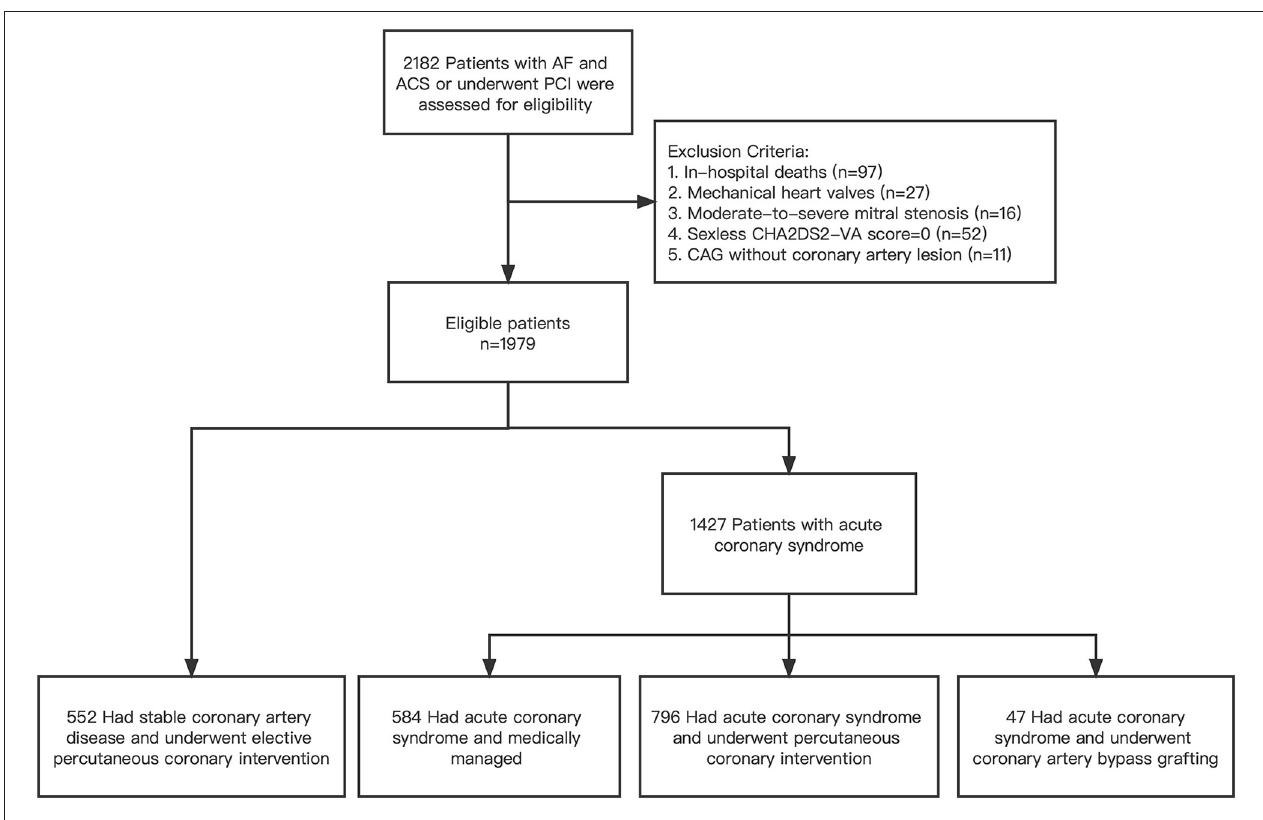
FIGURE 1 | Flowchart of